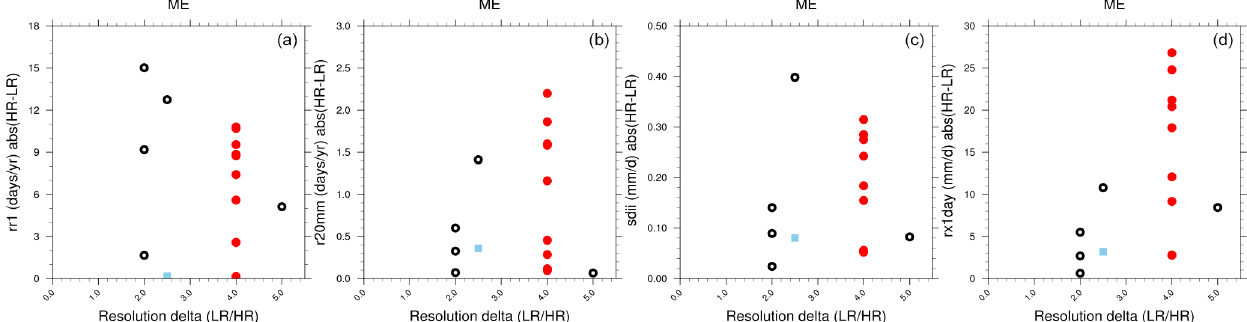
Figure 12. Absolute difference between HR and LR version of PRIMAVERA (black rings), CORDEX (red circles), and E-OBS (blue squares) in precipitation days (RR1, dyr − 1 , a ), number of days with precipitation amount over 20mm (R20mm, dyr − 1 , b ), simple precipi- tation intensity index (SDII, mmd − 1 , c ), and maximum 1d precipitation (Rx1day, mmd − 1 , d ) in the mid-European region (ME). The x axes show the resolution delta (LR divided by HR) for each model (example: 50km grid spacing divided by 12.5km equals